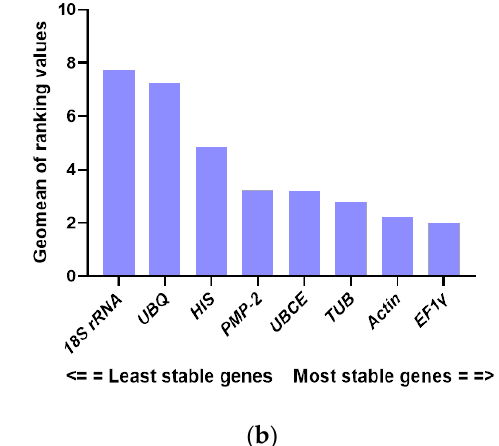
Figure 4. Expression stability of the candidate reference genes determined by RefFinder analysis. The average expression stability of the reference genes was calculated by the Geomean method of RefFinder. A lower Geomean value indicates more stable expression. ( a ) Different temperature treatments and ( b ) different developmental stages.